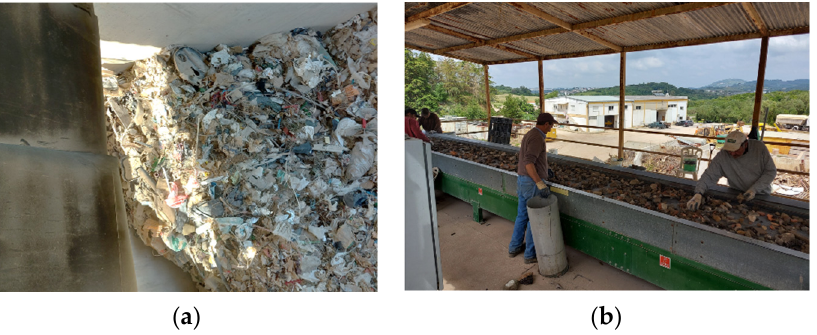
Figure 4. Traditional processes for the removal of unintended constituents(a) Lightweight materials removed by air sifting (b) Hand sorting